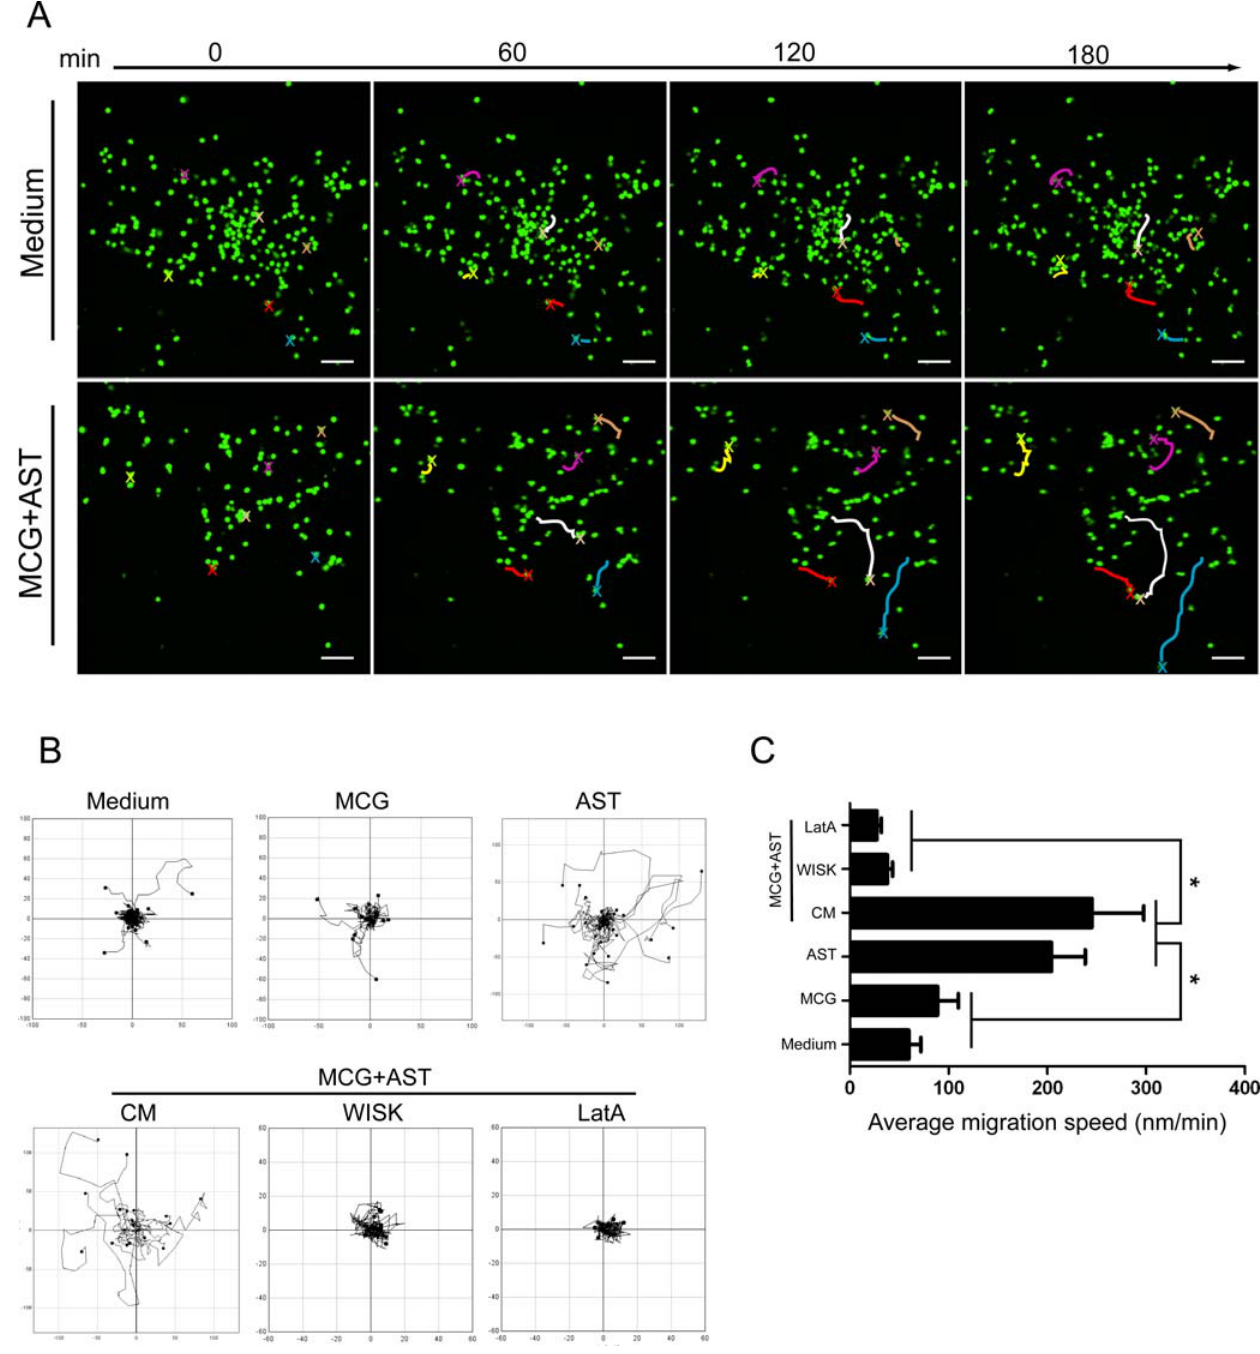
Figure 6. BMM mobility after exposure to micoglia/astrocvte conditioned media. Migration of CMFDA-labeled BMM was assessed for 3 h using confocal microscopy live imaging in m -slide chemotaxis assays comparing fresh media with conditioned media (CM) from microglia alone (MCG), astrocytes alone (AST) or microglia-astrocyte co-cultures (MCG + AST). Inhibitors wiskostatin (WISK, 20 m M) and latrunculin A (LatA, 0.2 m g/ml) were utilized to inhibit BMM migration. (A) Representative migrating BMM cultured in fresh medium (Medium) or CM fro microglia-astrocyte co- cultures (MCG + AST) were tracked (X’s in different color tracings) and evaluated at 60 min, 120 min, and 180 min. Scale bar, 10 m m; original magnification, 6 10. (B) Plots of each individual cell migration were generated from tracking data acquired for 3 h cultures in medium (Fresh Medium), CM from microglia (MCG), astrocytes (AST), or astrocyte-microglia co-cultures (CM), and in the presence of WISK and LatA inhibitors. Data were acquired by laser confocal microscopy and ImageJ software (NIH) interfaced with the ManulTrack plugin. (C) Migration velocities for each individual cell track were determined with the Chemotaxis and Tool software tool (ibidi). Significant differences in the mean 6 SEM migration velocities for n=50 determinations/group were assessed by two-tail Student’s t test where *p , 0.05 was considered significant.